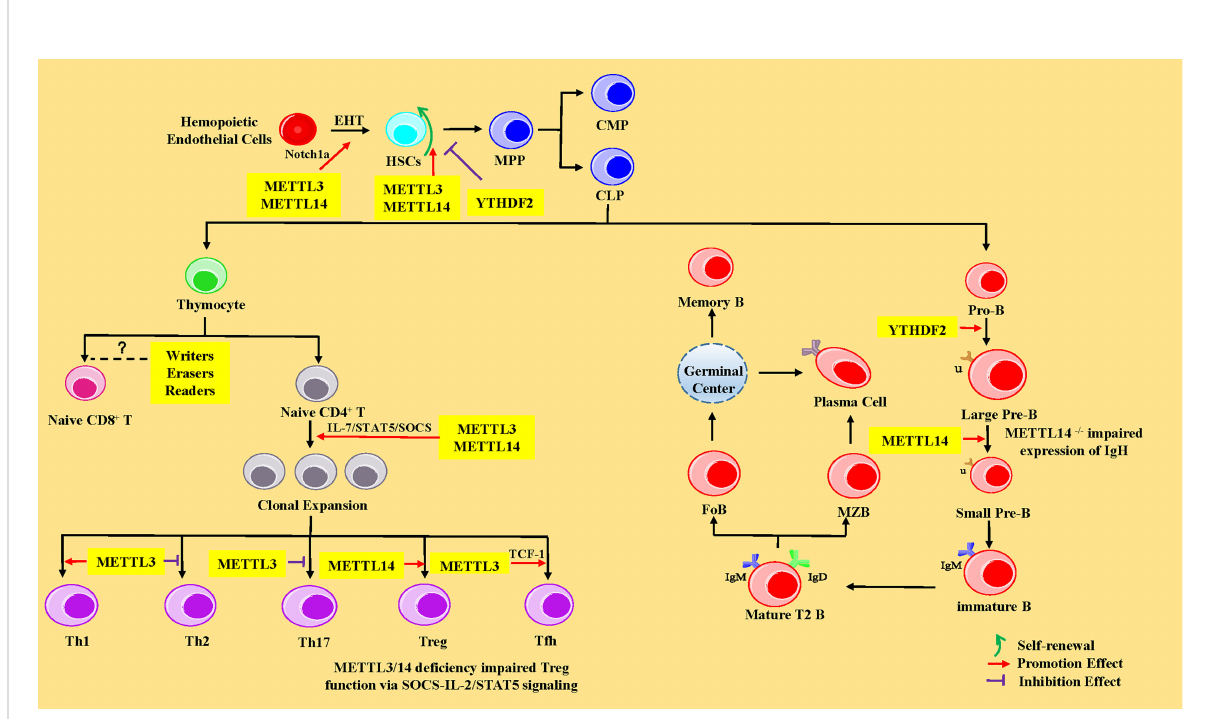
FIGURE 2 The regulatory role of m6A modi fi cation in HSCs, and T and B lymphocytes. In the HSCs, METTL3 and YTHDF2 promote endothelial-to- hematopoietic transition (EHT) via Notch1a leading to HSC generation. METTL3 and METTL14 enhance the ability of HSC self-renewal through MYC, whereas YTHDF2 inhibits HSC self-renewal by promoting the decay of mRNA encoding transcription factors, including TAL1, GATA2, RUNX1, and STAT5. MPP, multipotent progenitor cells; CMP, common myeloid progenitors; CLP, common lymphoid progenitors. In CD4 + T cells, METTL3 and METTL14 promote naive CD4 + T-cell proliferation by the IL-7/STAT5/SOCS pathway. Meanwhile, METTL3 promotes the differentiation of Th1 and Tfh cells, but represses Th2 and Th17 cell differentiation. METTL14 promotes Tregs differentiation, and METTL3/14 is essential for the suppressive function of Tregs. However, the exact roles of m 6 A modi fi cation in CD8 + T cells is unknown. In B cells, YTHDF2 and RBM15 promote pro-B-to-large-pre-B transition, and METTL14 promotes the transition from large pre-B cells to small pre-B cells via increasing chromatin accessibility of key transcription factors loci ( Ikzf3, Irf4, Spib , and Bcl6 ). However, loss of METTL14 did not affect IgH recombination, but might impair the expression of recombined IgH. IGF2BPs promote the differentiation of MZB and FoB by enhancing the stability of B-cell regulators Pax5 and Arid3a mRNA. Pro-B, progenitor B cells; Large Pre-B, large precursor B cells; Small Pre-B, small precursor B cells; MZB, marginal zone B cells; FoB, follicular B